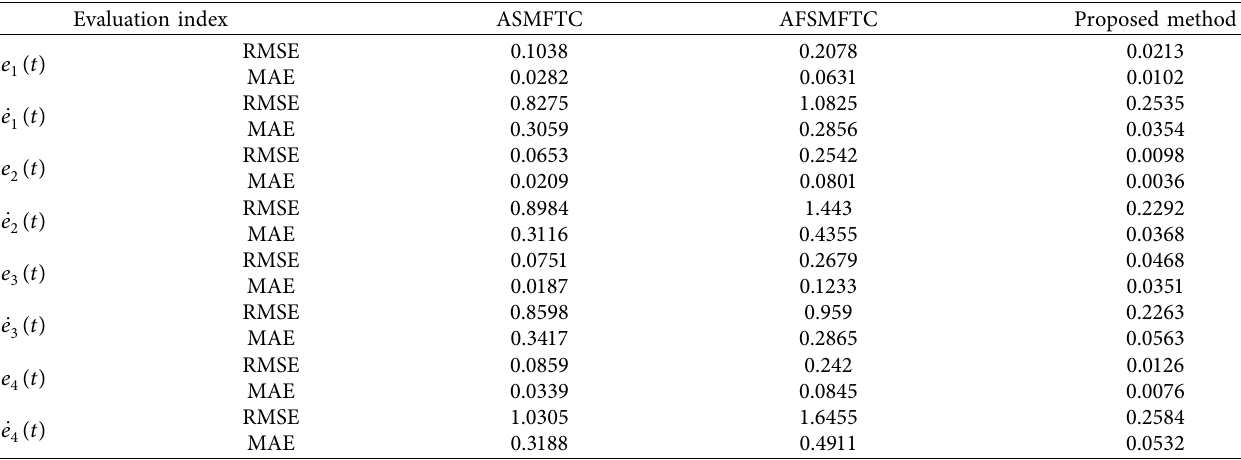
Figure 6: The position interval errors of MHSTs using different fault-tolerant control methods. (a) The position interval error of train 1. (b) The position interval error of train 2. (c) The position interval error of train 3. (d) The position interval error of train 4. Table 2: The comparison of position interval and speed tracking